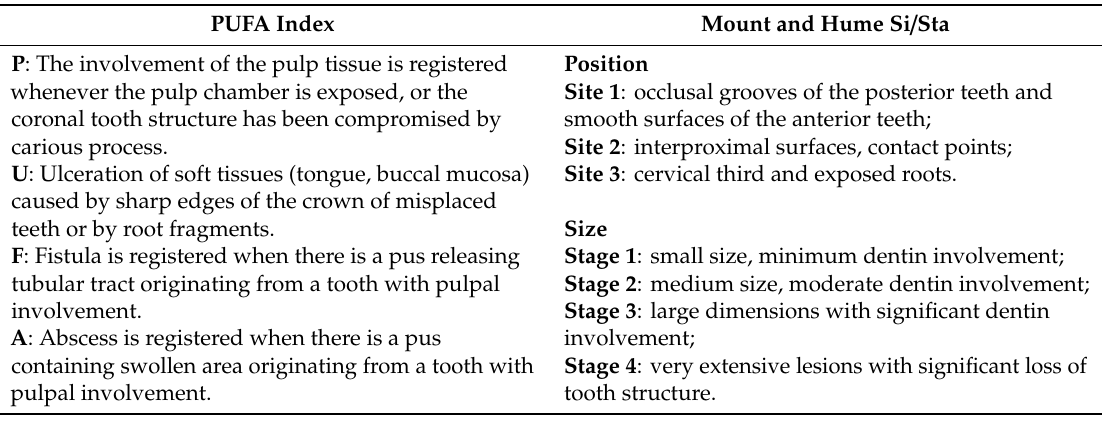
Table 1. Dental caries